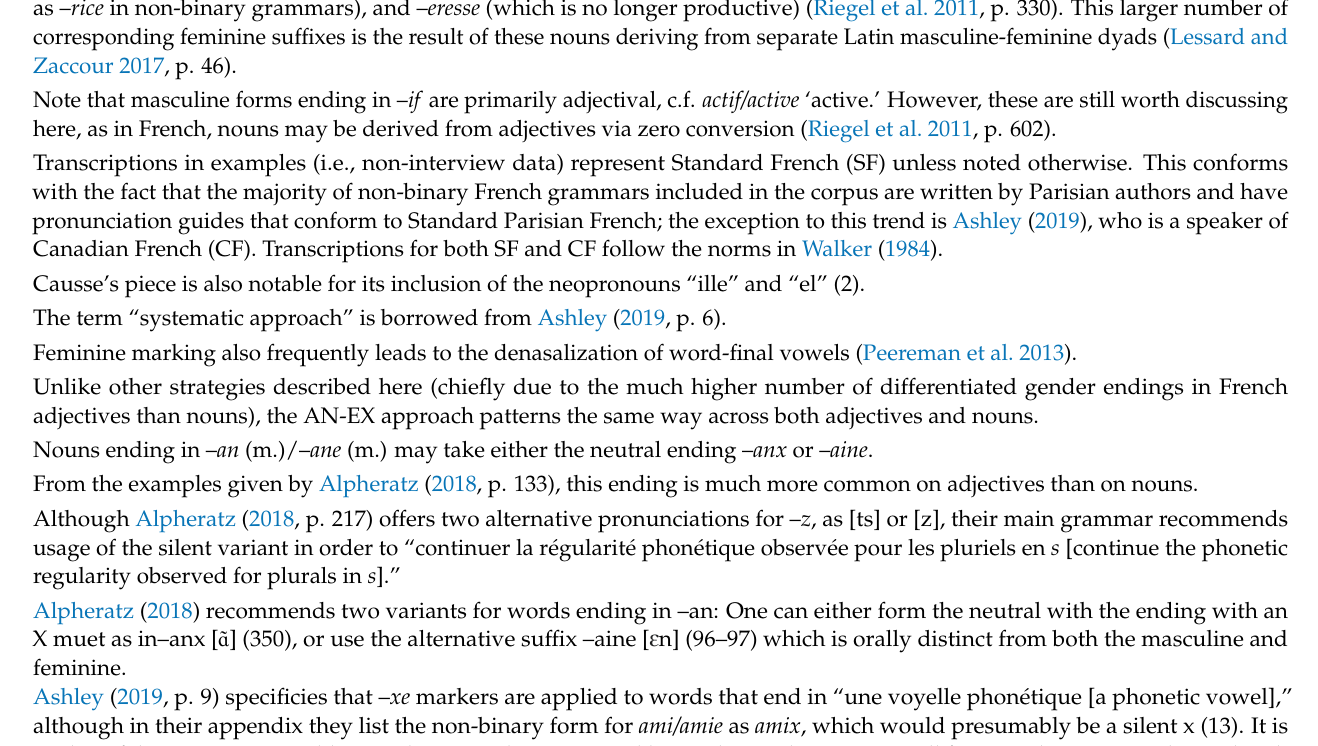
Table 1. Gender and Number Distinctions in Written and Oral French. Singular Plural